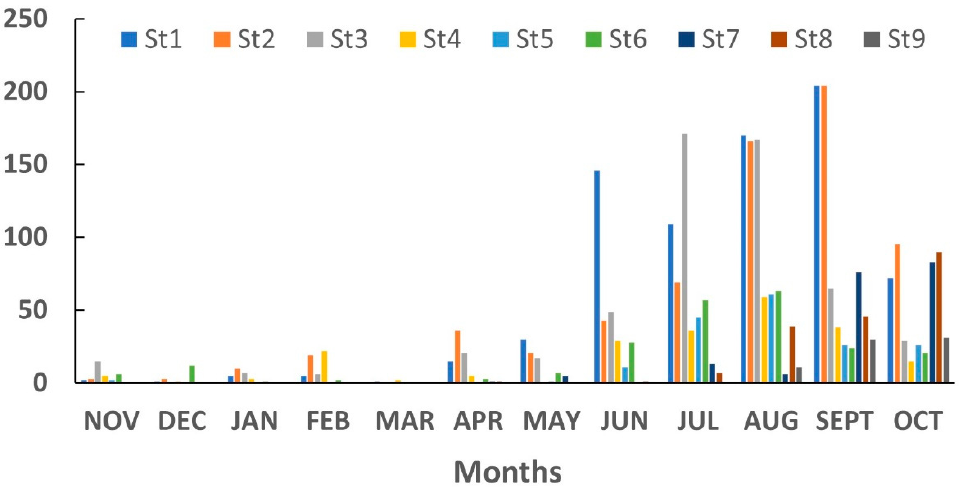
Figure 2. Catch per unit effort (crabs/10 pairs of fyke nets) of the blue crab Callinectes sapidus per station (st. 1–st. 9) and per month (November 2020–October 2021) in Monolimni Lagoon and